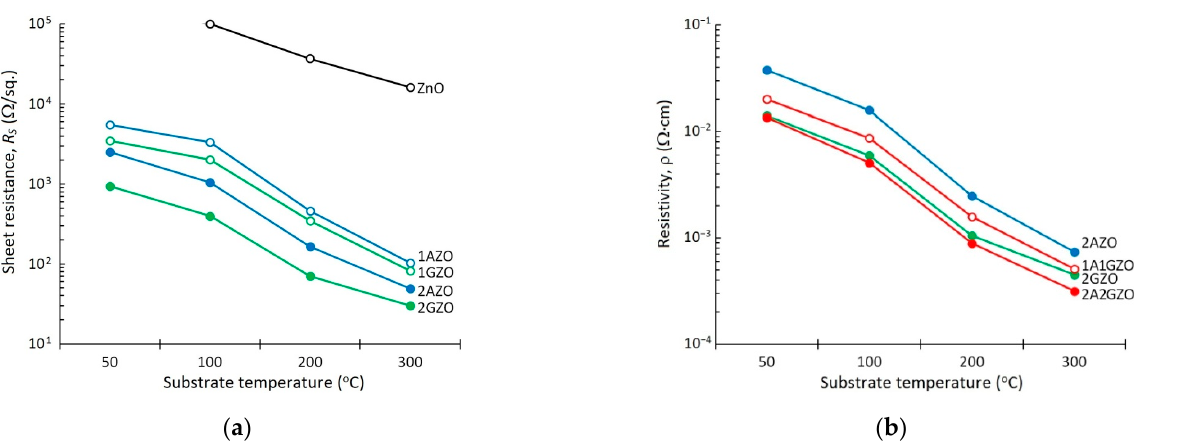
Figure 1. ( a ) Sheet resistance of pure ZnO and ZnO thin films single-doped with Al or Ga (1AZO, 1GZO, 2AZO, and 2GZO) as a function of substrate temperature; ( b ) resistivity of single-doped (2AZO, 2GZO) and co-doped (1A1GZO and 2A2GZO) thin films as a function of substrate temper- ature.